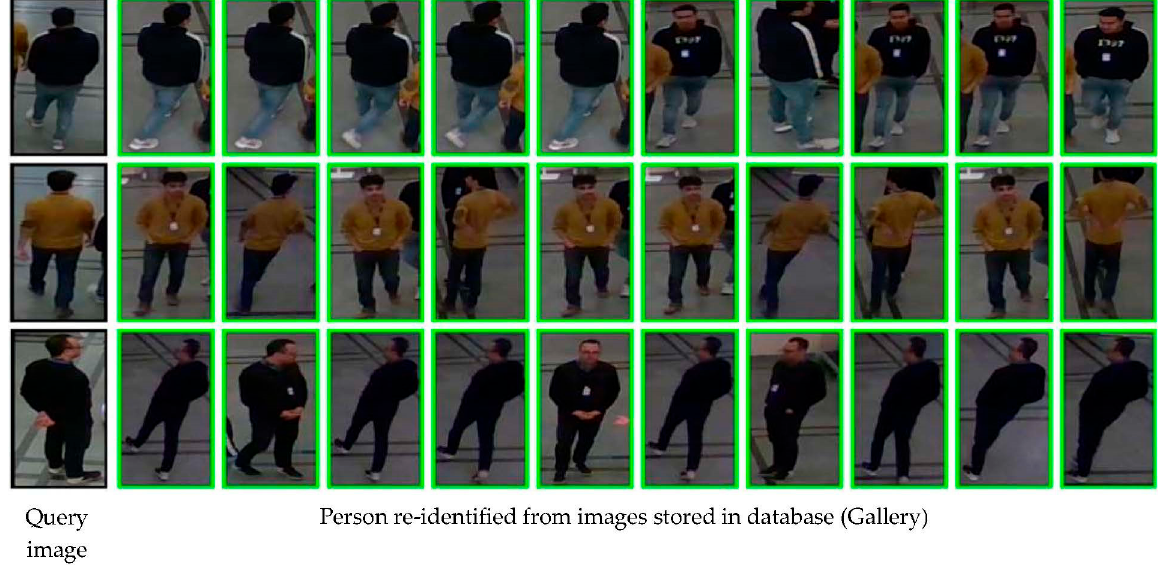
Figure 10. Images of persons re-identified by re-identification module based on images stored in database (Gallery) and given query images.